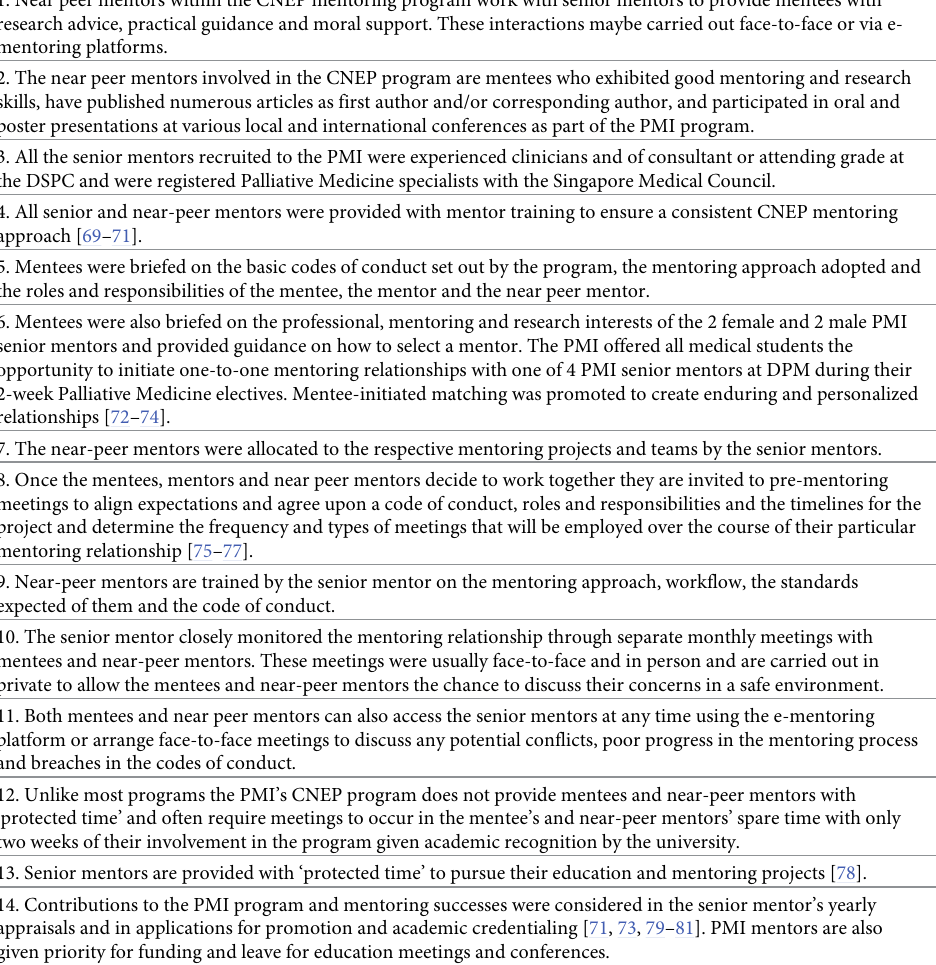
Table 1. The PMI CNEP mentoring